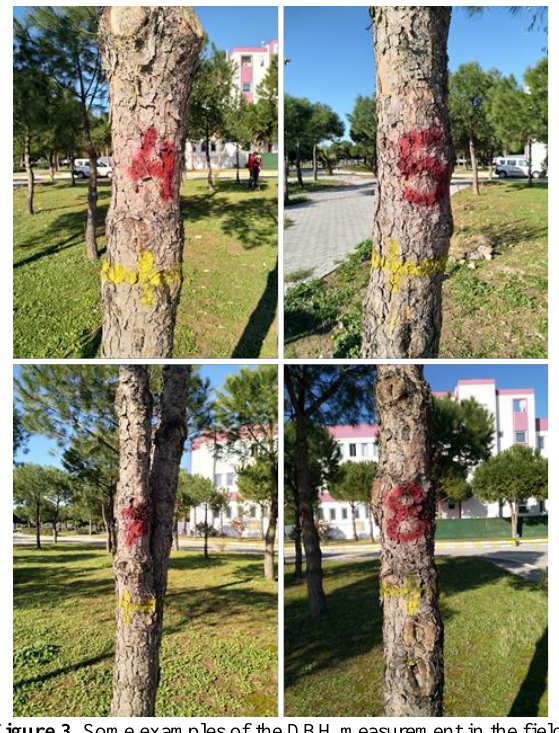
Figure 3. Some examples of the DBH measurement in the field